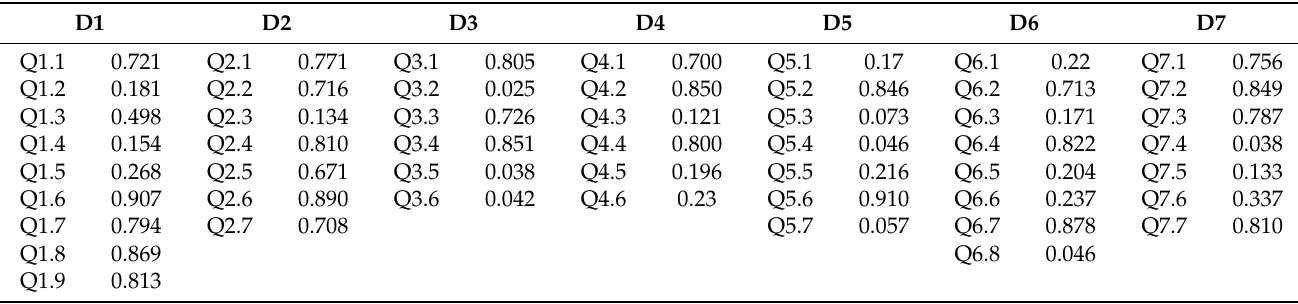
Table 6. The correlation between each attribute and the overall satisfaction in each dimension of the